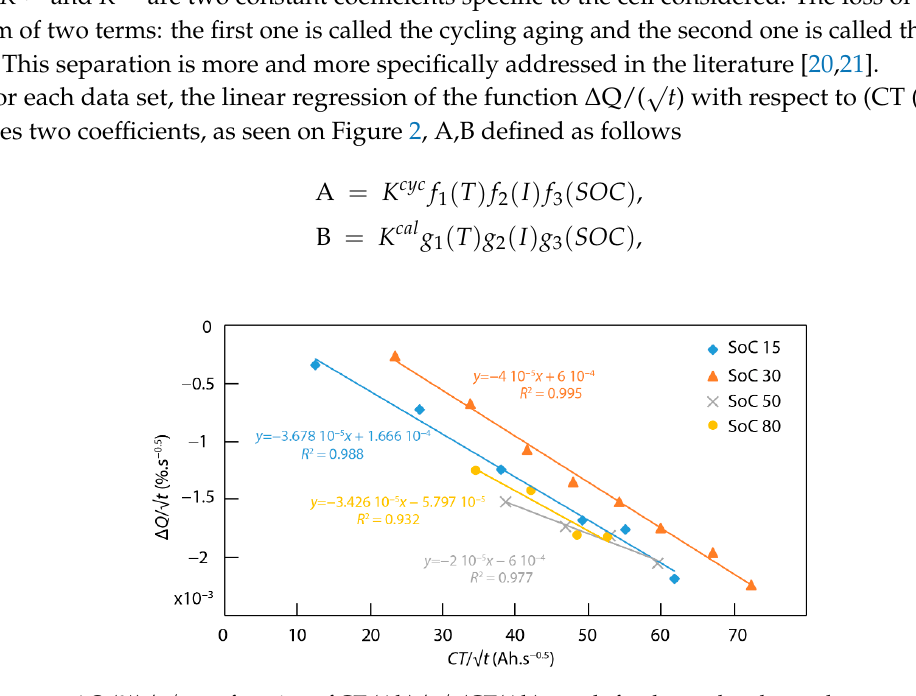
Figure 2. Δ Q (%)/ √ t as a function of CT (Ah)/ √ t (CT(Ah) stands for the total exchanged